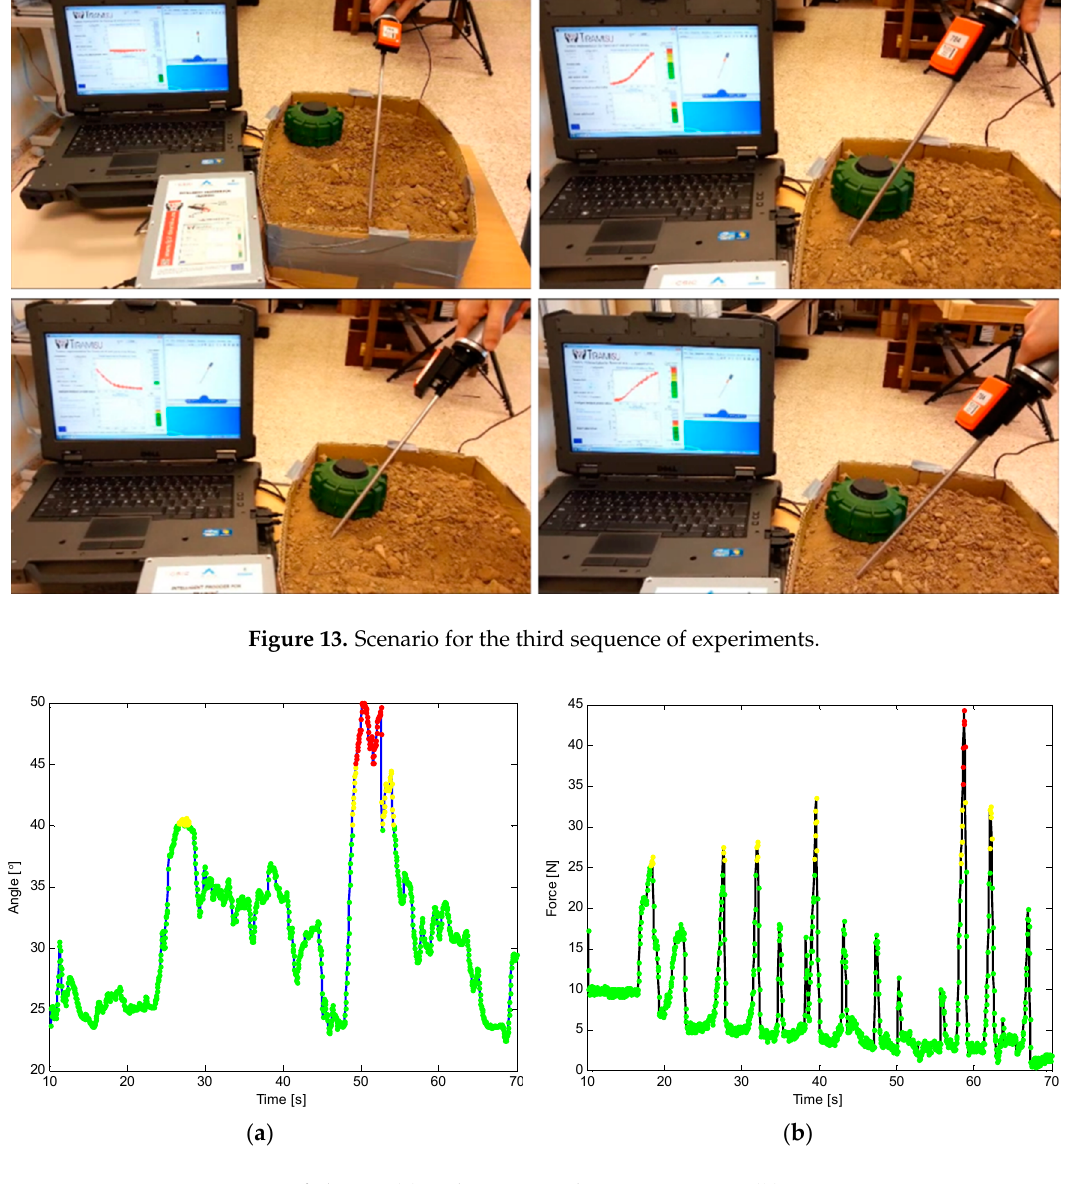
Figure 14. Activation of alarms: ( a ) Inclination angle measurements; ( b ) Force measurements.